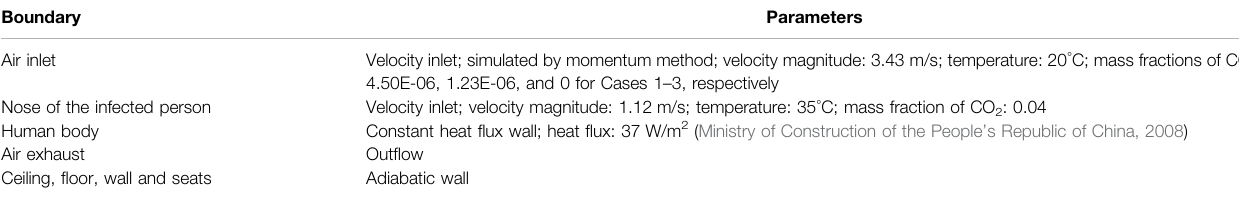
TABLE 2 | Boundary conditions.